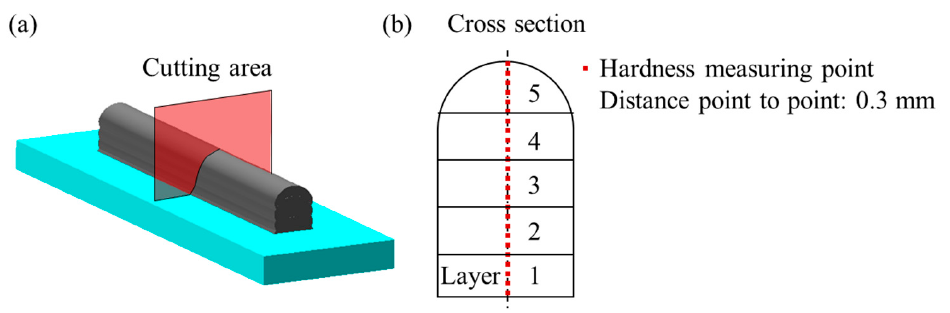
Figure 3. ( a ) Cutting area for material analysis, ( b ) cross section for microstructure and hardness determination.